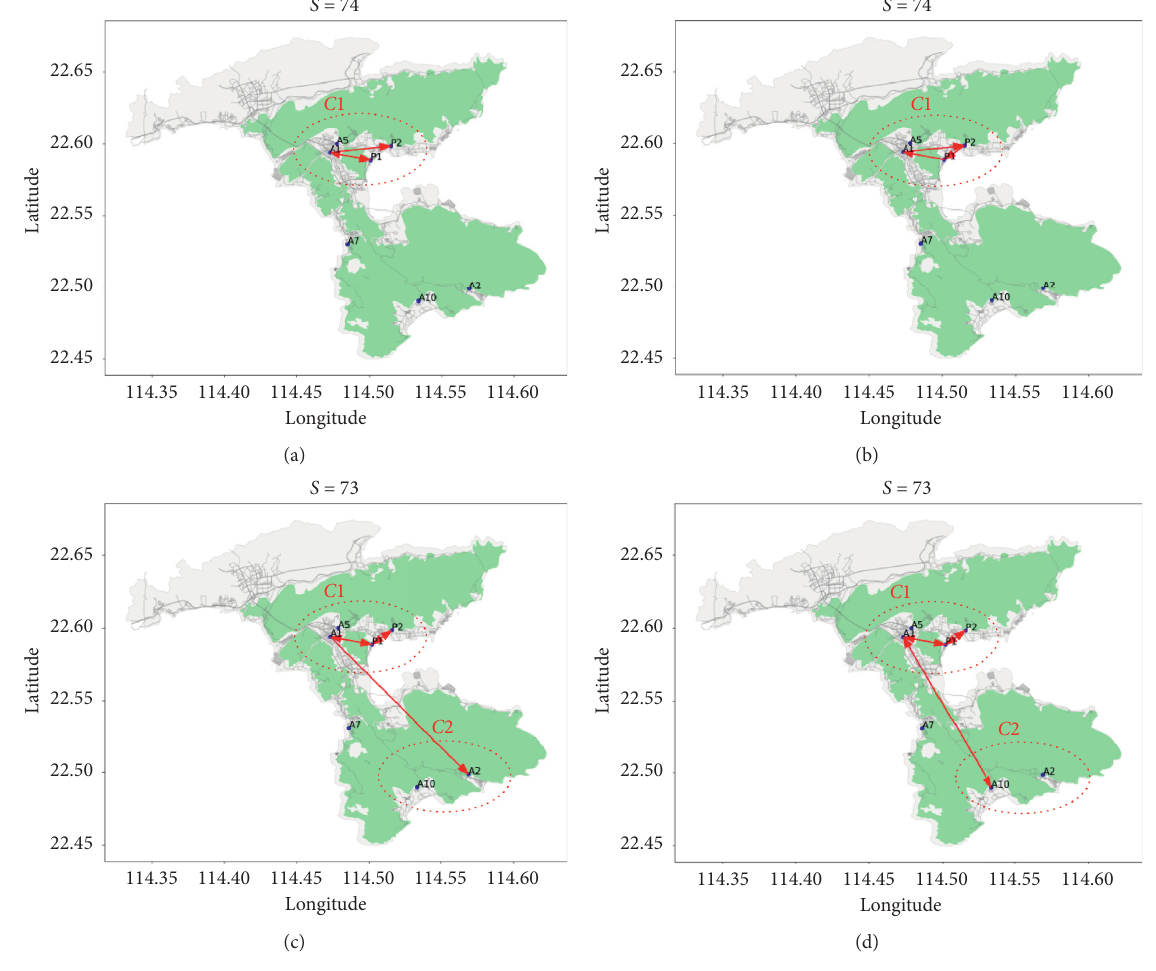
Figure 8: Flow patterns inferred from intracity tourists. Table 3: The list of flow patterns inferred from intracity tourists. Figures